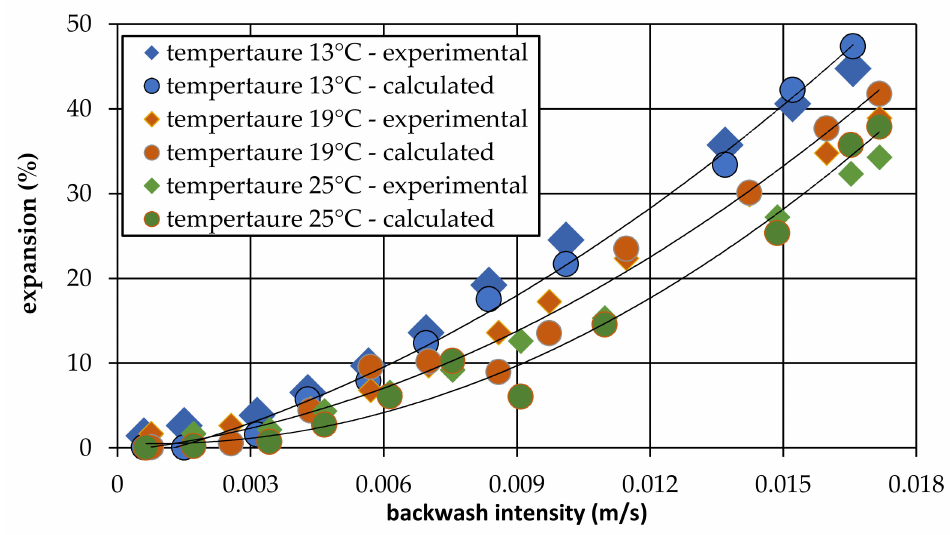
Figure 4. Measured and computed values of sand bed expansion p (%) as a function of flushing intensity for flushing water temperatures of 13 ◦ C, 19 ◦ C, 25 ◦ C together with trend lines.